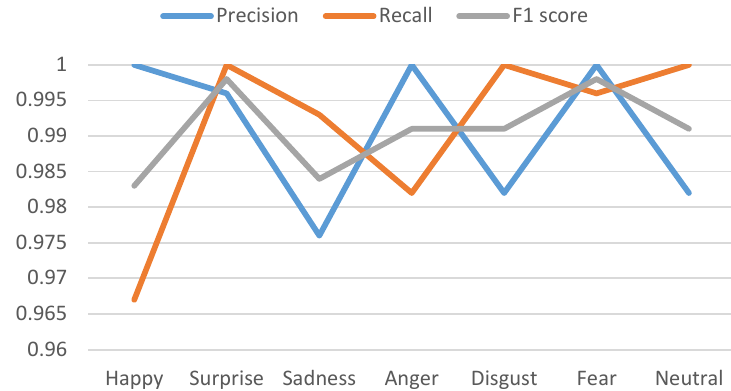
Figure 13. Dataset: CK+, Precision, Recall and F1 score shown for SVM.